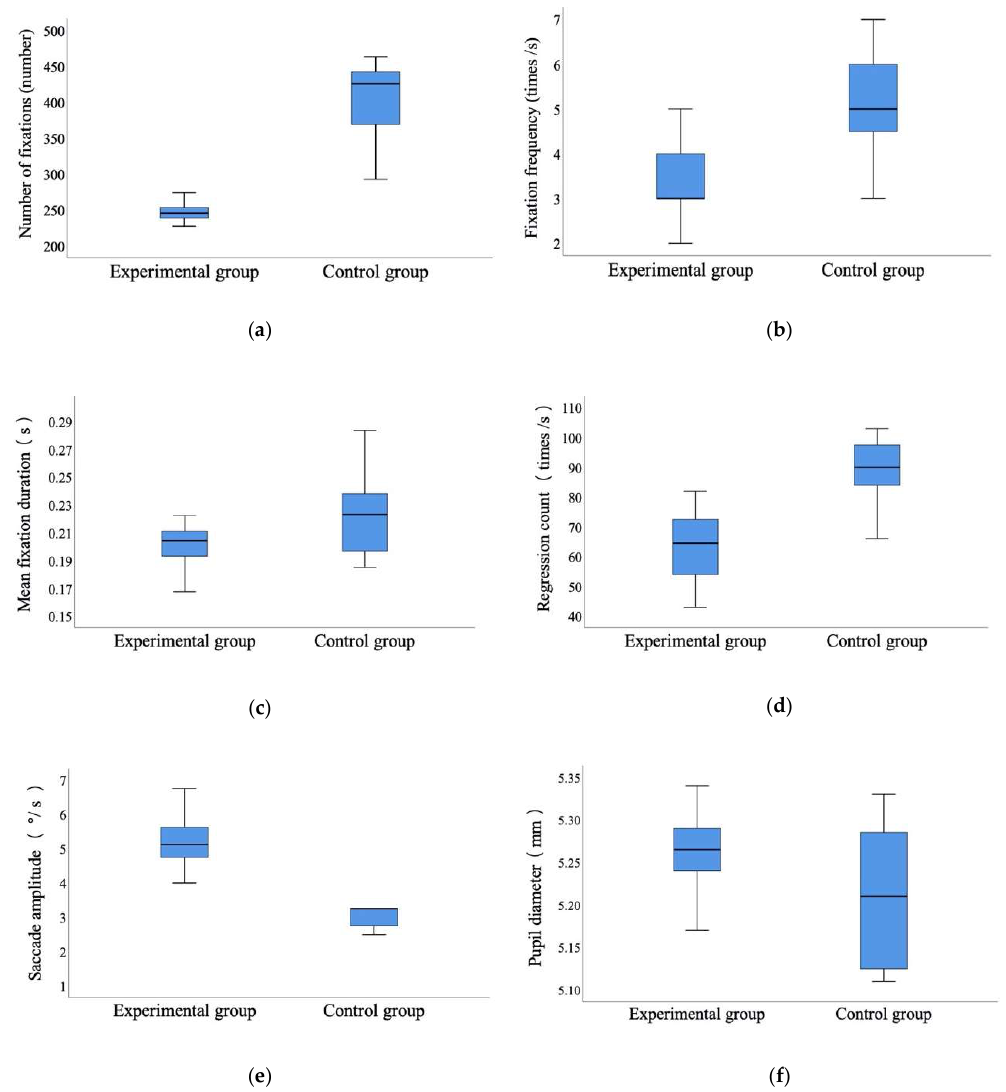
Figure 5. Statistical comparison of number of fixations, fixation frequency, mean fixation duration, regression count, and saccade amplitude for the two groups. ( a ) number of fixations; ( b ) fixation frequency; ( c ) mean fixation duration; ( d ) regression count; ( e ) saccade amplitude; and ( f ) pupil diameter.